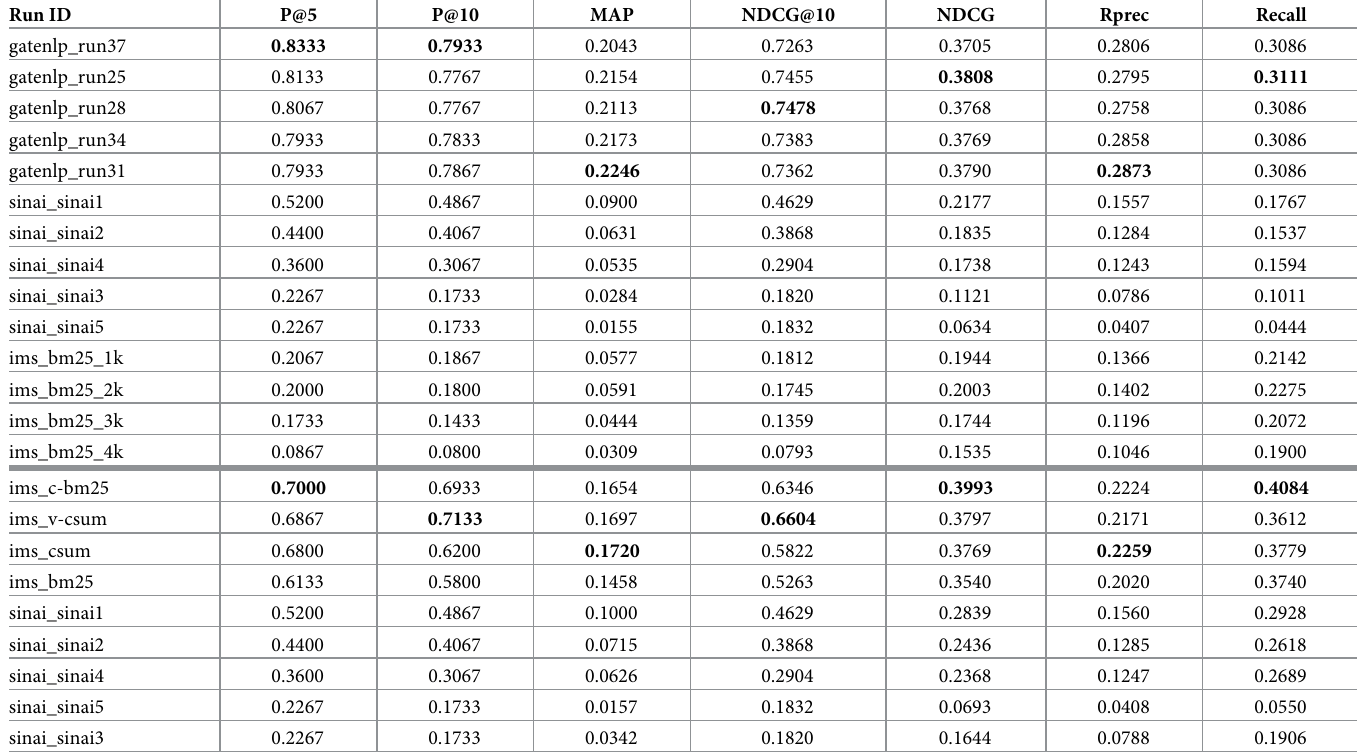
Table 4. Results for monolingual Spanish runs. Our runs have gatenlp_ as a prefix in the name of the run. The first part of the table contains runs which retrieve 200 documents per query and the second part of the table contains runs which retrieve 1000 documents for each query. Best overall scores are highlighted in bold.